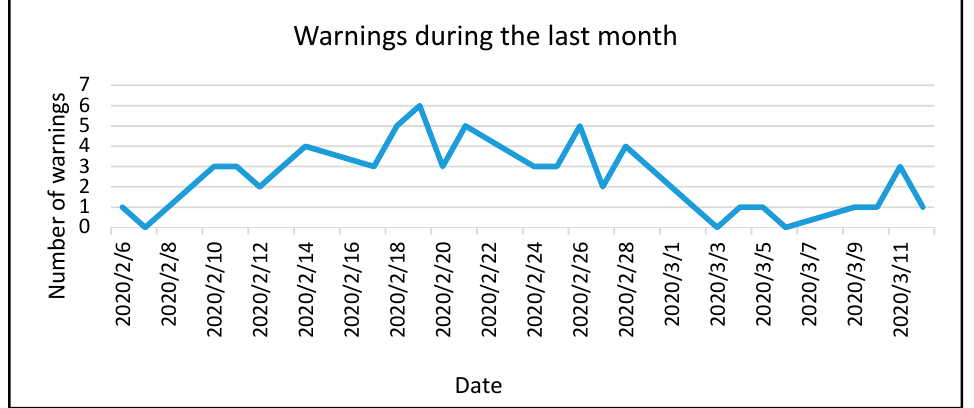
Figure 18. Number of warnings evolution during the last month.